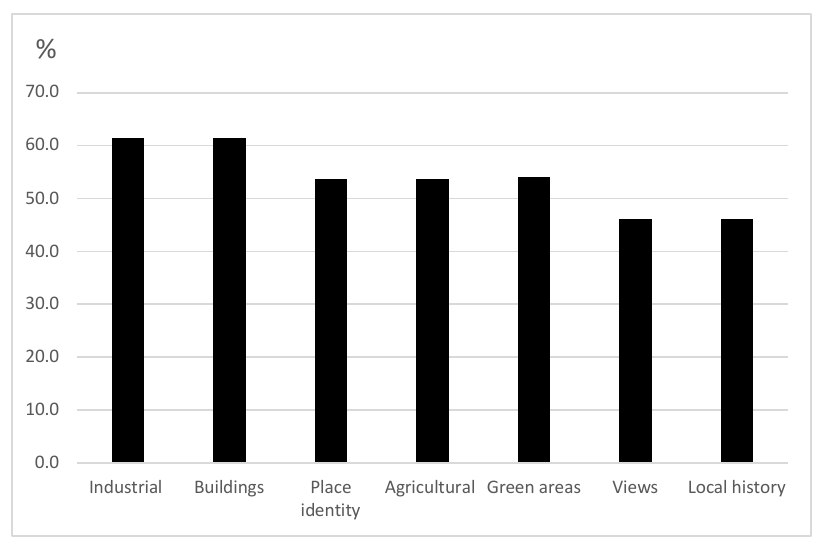
Figure 2. The x -axis shows the seven most important historic and cultural landscape dimensions that are regularly considered in the planning process (measured as percentage, y -axis). See also Table 1, closed-ended questions.